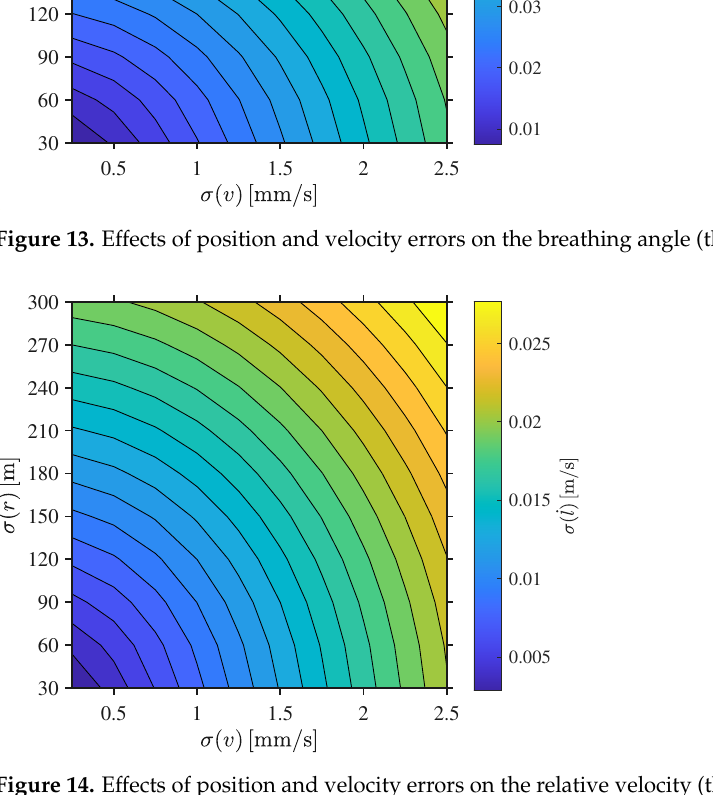
Figure 14. Effects of position and velocity errors on the relative velocity (three months’